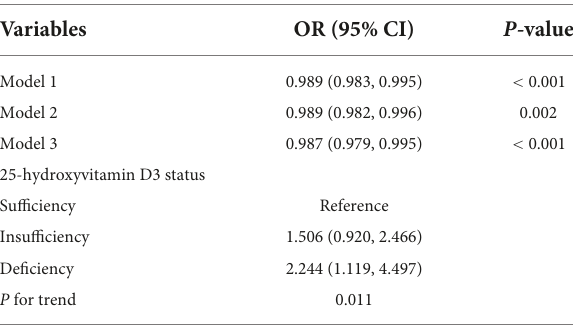
TABLE 3 The association between VitD3 and Frailty in the multiple regression model.